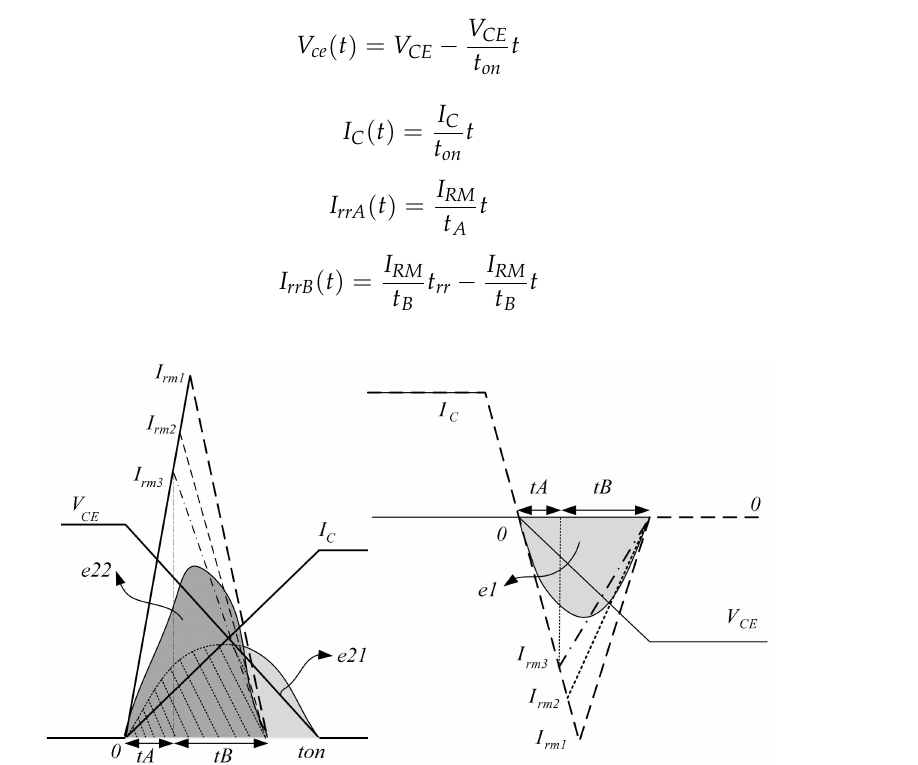
Figure 7. The diagram of the turn-on and reverse recovery loss calculation of the